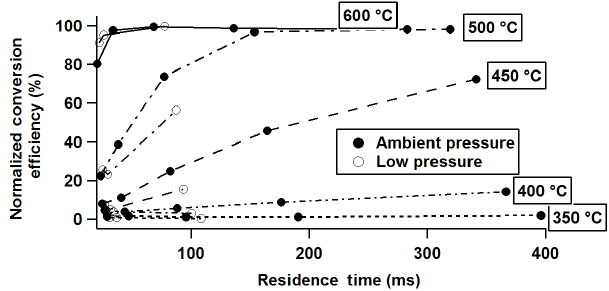
Figure 3. Conversion efficiencies of HNO 3 to NO 2 plotted as a function of plug flow residence times in the oven (see text) for five different temperatures. Values were obtained by scaling the mea- sured conversion efficiency in Fig. 1 to the overall maximum and minimum of the thermogram, to account for slight differences be- tween thermograms. Solid circles indicated measurements at am- bient pressure, whereas open circles indicate measurements at low pressure. Different line traces indicated different temperatures. A temperature set point between 350 (short dashed line) and 450 ◦ (long dashed line) and a residence time less than 200ms are the conditions normally selected for selective detection of alkyl nitrates with no detection of HNO 3 . However, under these conditions HNO 3 conversion may be anywhere between 1 and